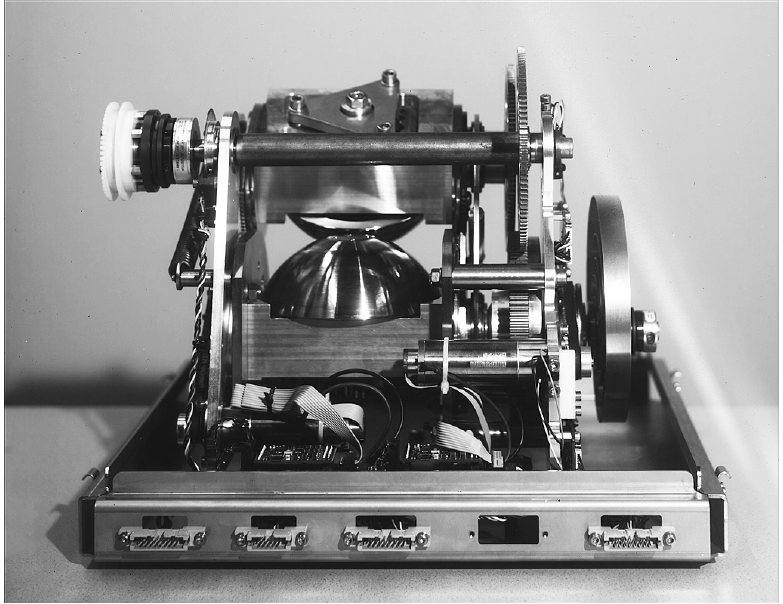
Figure 11. A photo of the Dual-Hemi CVT. Photo by Wanda